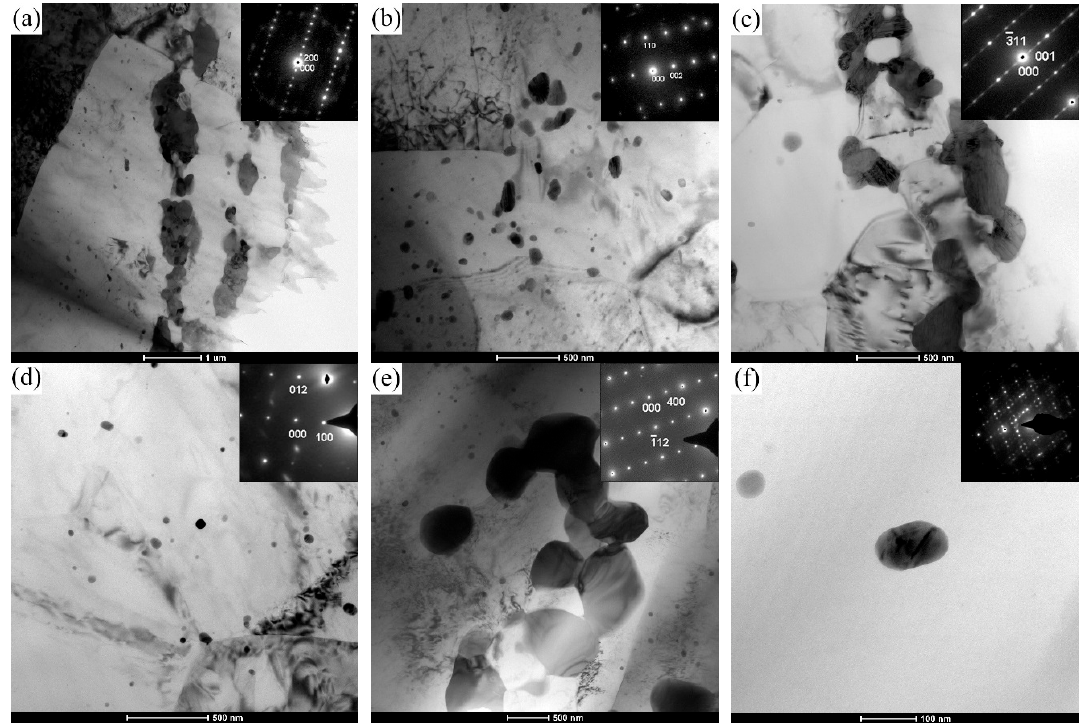
Figure 5. Transmission electron microscopy (SEM) micrographs of Mg-6Zn alloy processed by ECAP for six passes ( a , b ) at 160 °C, ( c , d ) at 200 °C, and ( e , f ) at 240 °C.